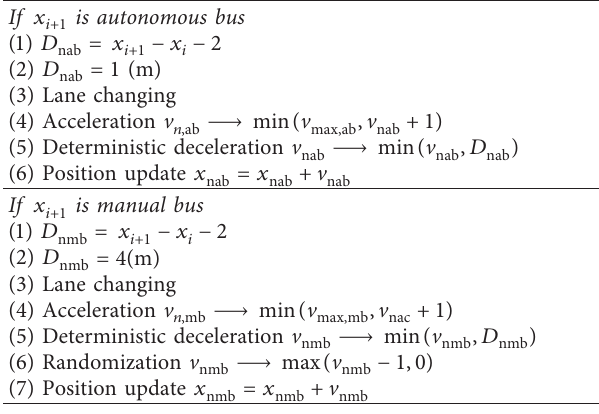
Table 3: Rules for updating the position of different buses in the